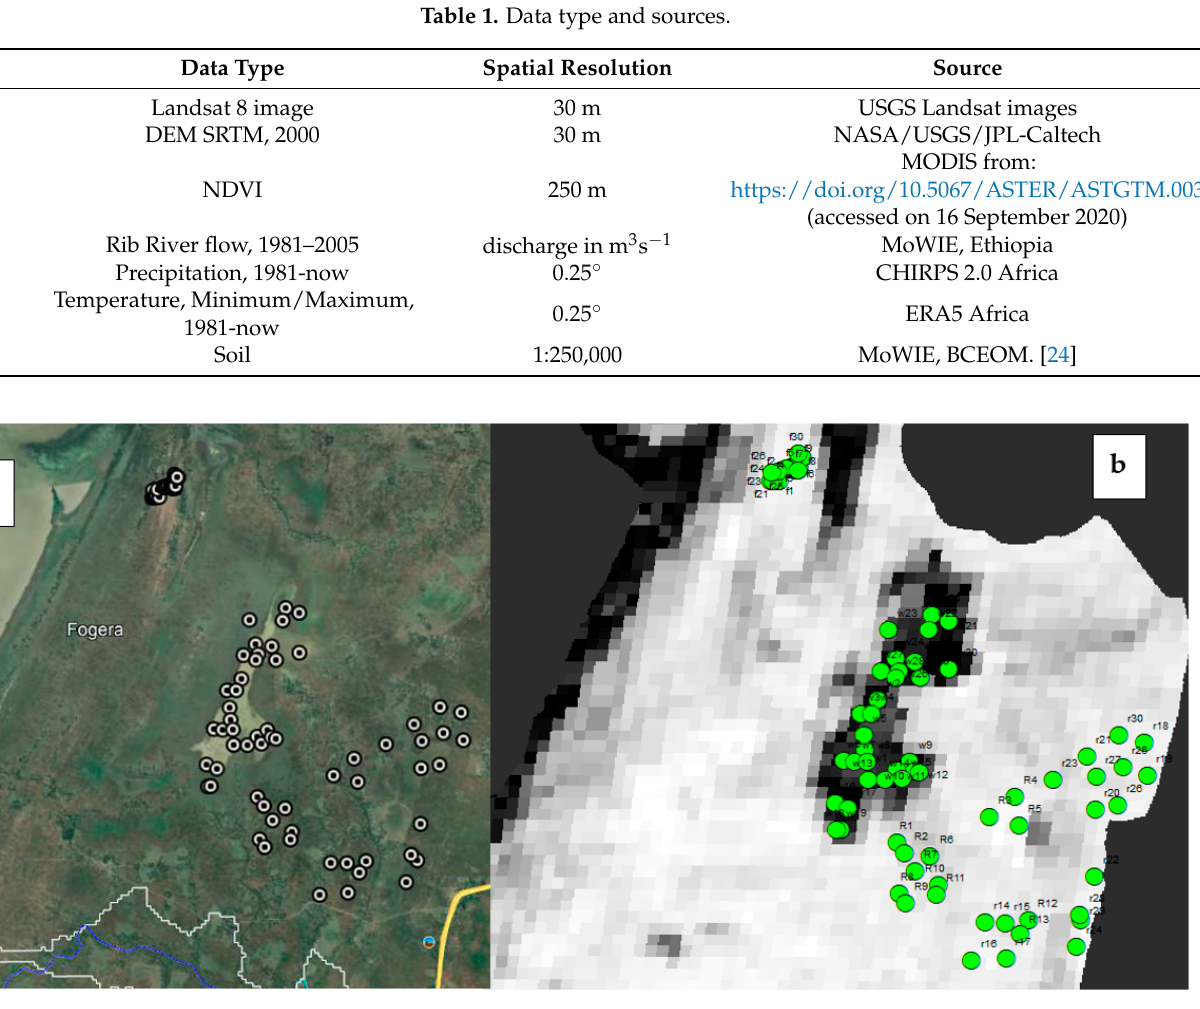
Figure 2. Land use/cover ground truth points in the Fogera floodplain. ( a ) Ground truth points mapped on Google Earth map (white circles), and ( b ) ground truth points mapped on NDVI map (green circles).